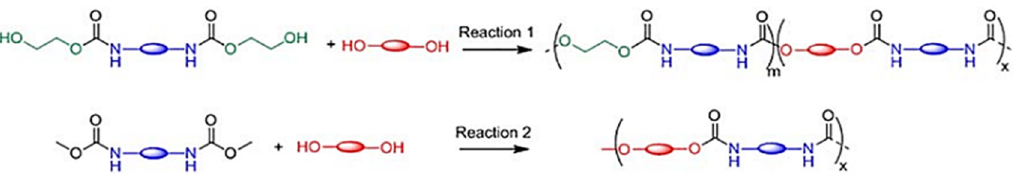
Figure 42. Two reactions related to transurethane polycondensation. From reference